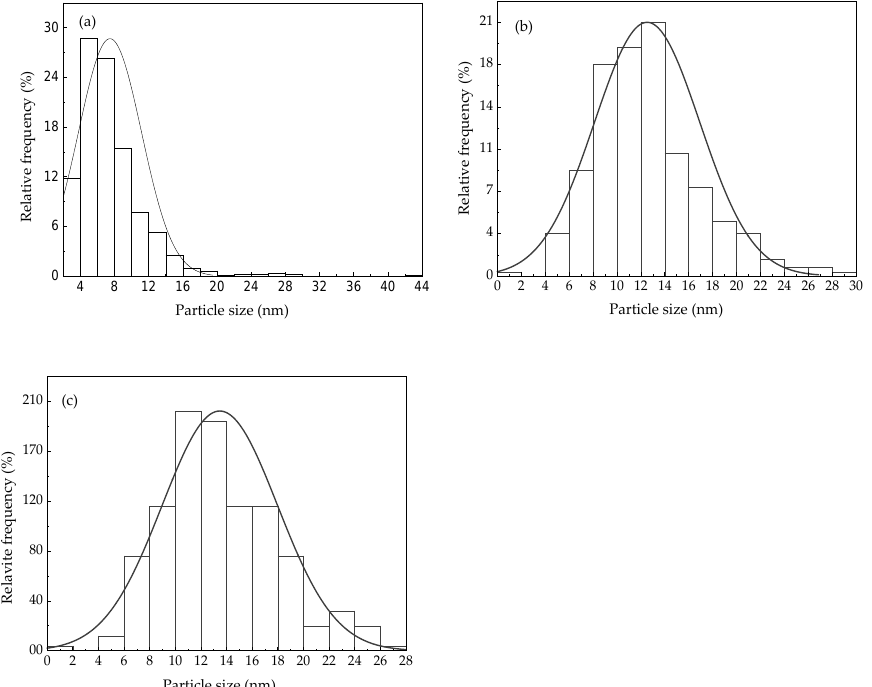
Figure 2. TEM images of precipitates in ( a ) HR sample; ( b ) EF1 sample; ( c ) EF2 sample. The size distribution of the precipitates in the HR, EF1, and EF2 samples is displayed in Figure 3. In order to accurately measure the size of the precipitates, 10 TEM photos were taken for analysis of each sample. The number of analyzed precipitates in the HR, EF1, and EF2 samples was approximately 8300, 1600, and 1200, respectively. The relative frequency of the precipitates is largest when the precipitate size is 2–4 nm in the HR sam- ple, and when the precipitate size was approximately 12–14 nm and 10–12 nm in the EF1 and EF2 samples.